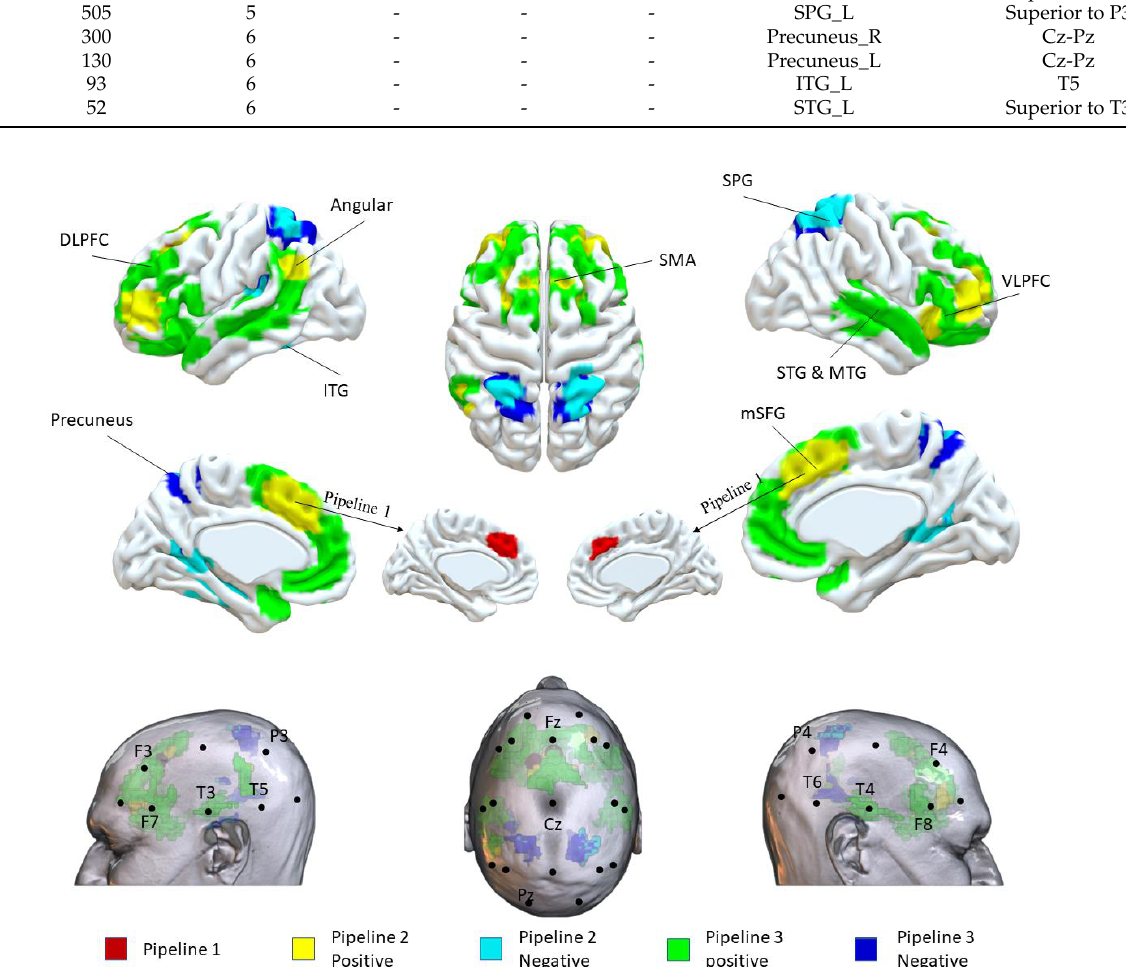
Figure 1. Potential targets for NIBS. Table 3. Potential targets identified from three pipelines.